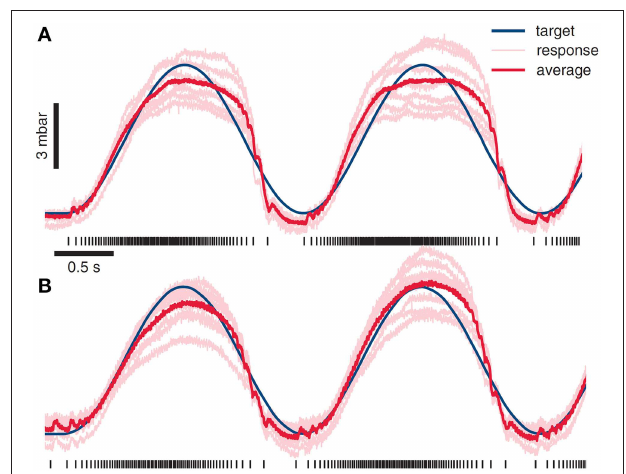
FIGURE 6 | ISMS stimulus combination used as a basis for driving of force generation and behaviors. The value of ISMS and modular approaches are the potential simplicity of control and a unified framework for motion and interaction controls. Using a muscle model and ISMS Zimmermann and colleagues have driven grip force using ISMS at sites producing hand grasp motions. Reproduced from Zimmermann et al. (2011) with permission. (A) An integrate and fire model used in grip force control generates forces with r-squared of 0.92 in relation to desired target force. (B) A more sophisticated muscle models allows ISMS control of grip force with r-squared of